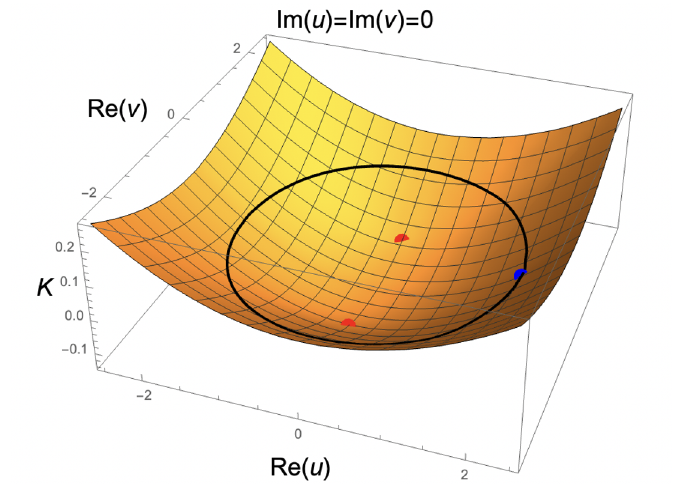
(a) K plotted in the Re u - Re v plane, with Im u = Im v = 0 , evaluated on a grid with spacing δ Re u = δ Re v = 0 . 25 . This slice includes the two Argyres-Douglas points, indicated by the red dots, and one of the multi-monopole points, indicated by the blue dot.